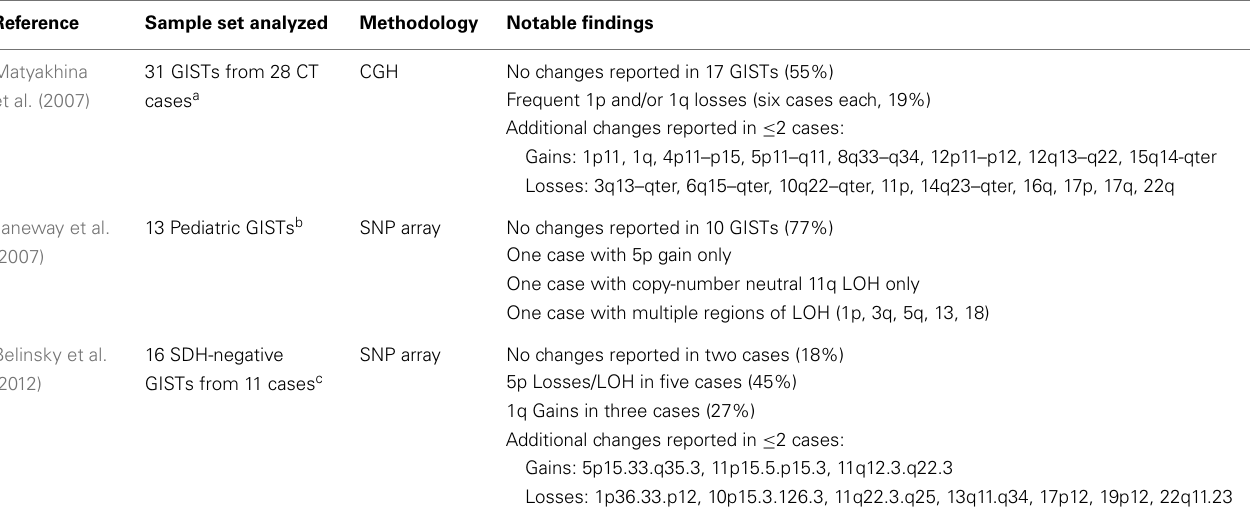
Table 3 | Reported chromosomal aberrations in wild type